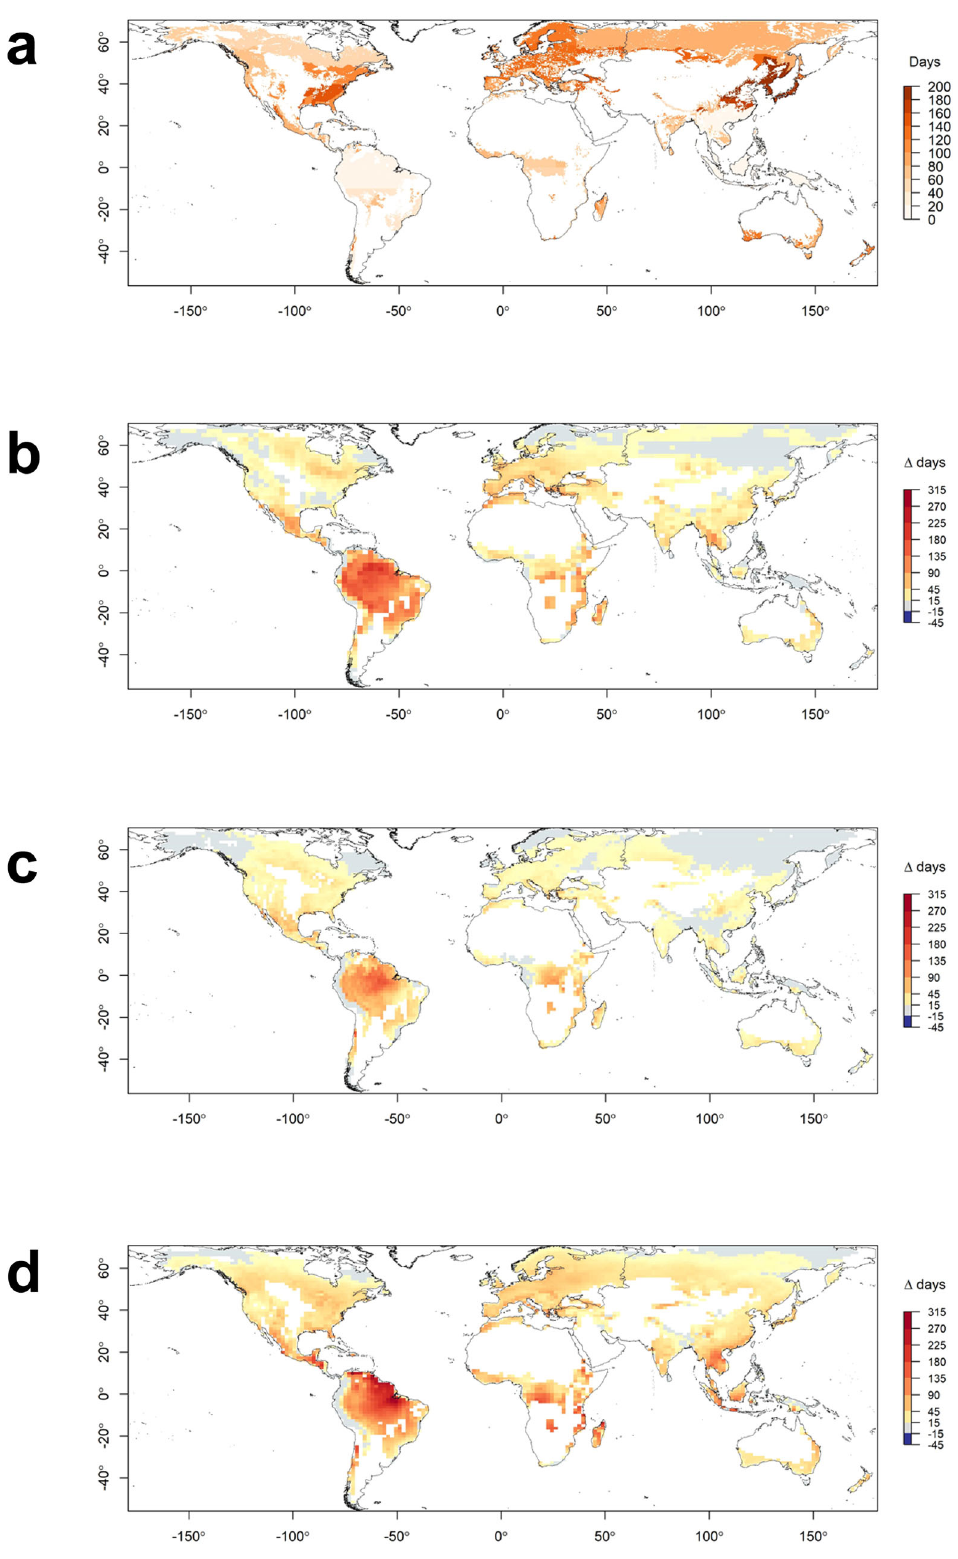
Fig. 3 | Themean annual frequency ofdailyVPD threshold exceedances (days) for global forestbiomes. Current frequencybased onERA5data (2003-2020) ( a ) andtheprojectedchangeinthenumberofdaysoverVPDthresholdby2081 – 2100